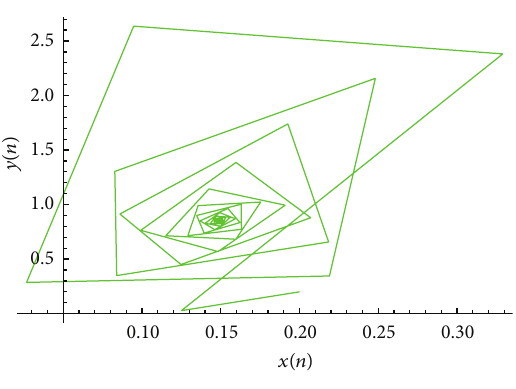
Figure 3: An attractor of the system (51).